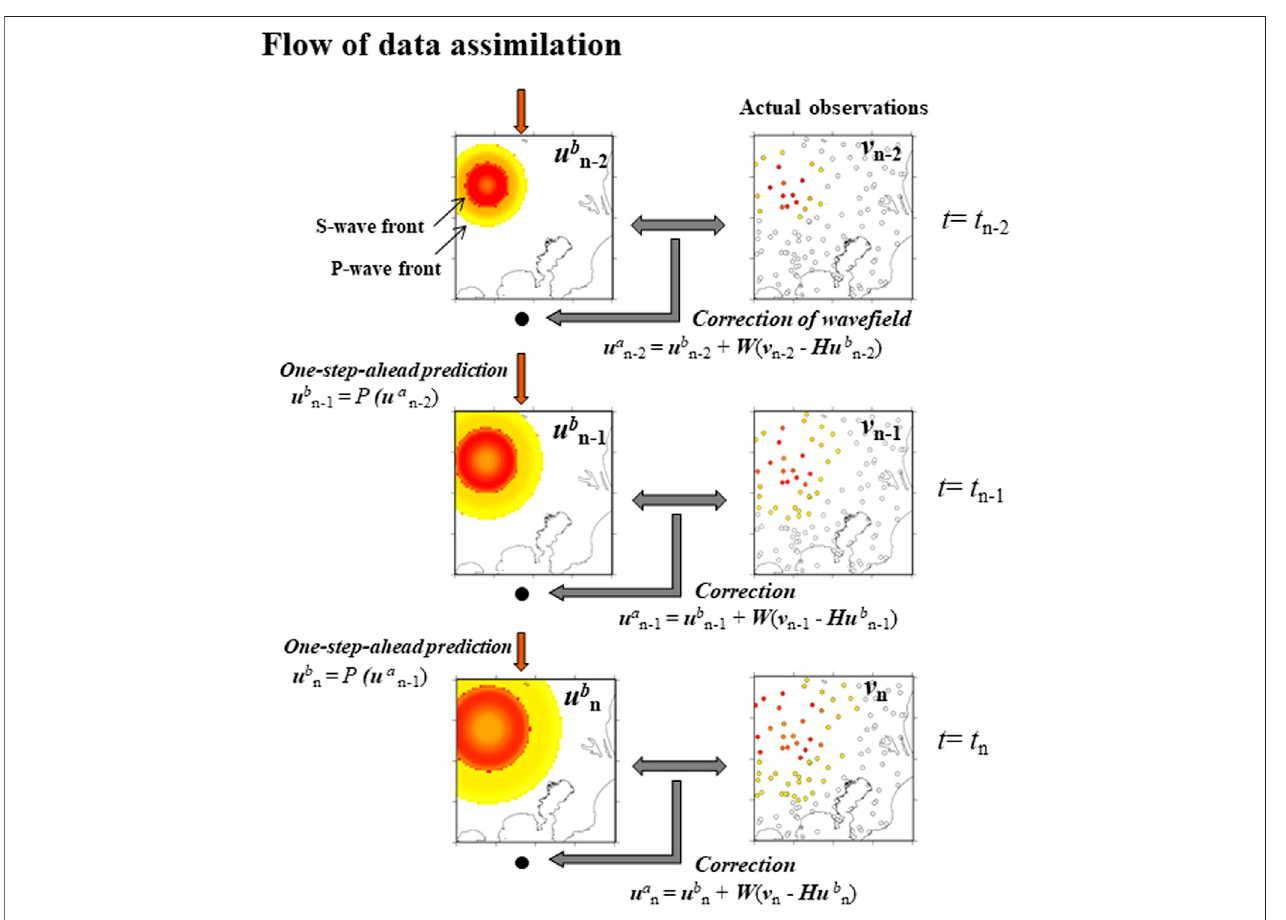
FIGURE4| The fl owofthedataassimilationprocess. One-step-aheadprediction, u b n (cid:2) P ( u a n-1 ),iscombinedwithactual observations, v n , tocorrect theestimation of the current wave fi eld (after Hoshiba and Aoki, 2015). By repeating this process, the current wave fi eld, u a n , is estimated by using not only the current observation ( v n ), but also all past observations ( v n-1 , v n-2 , v n-3 , ... ).